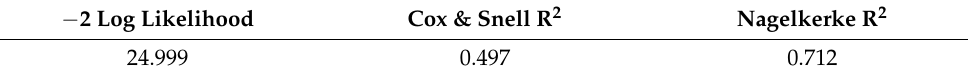
Table 6. Model Summary.